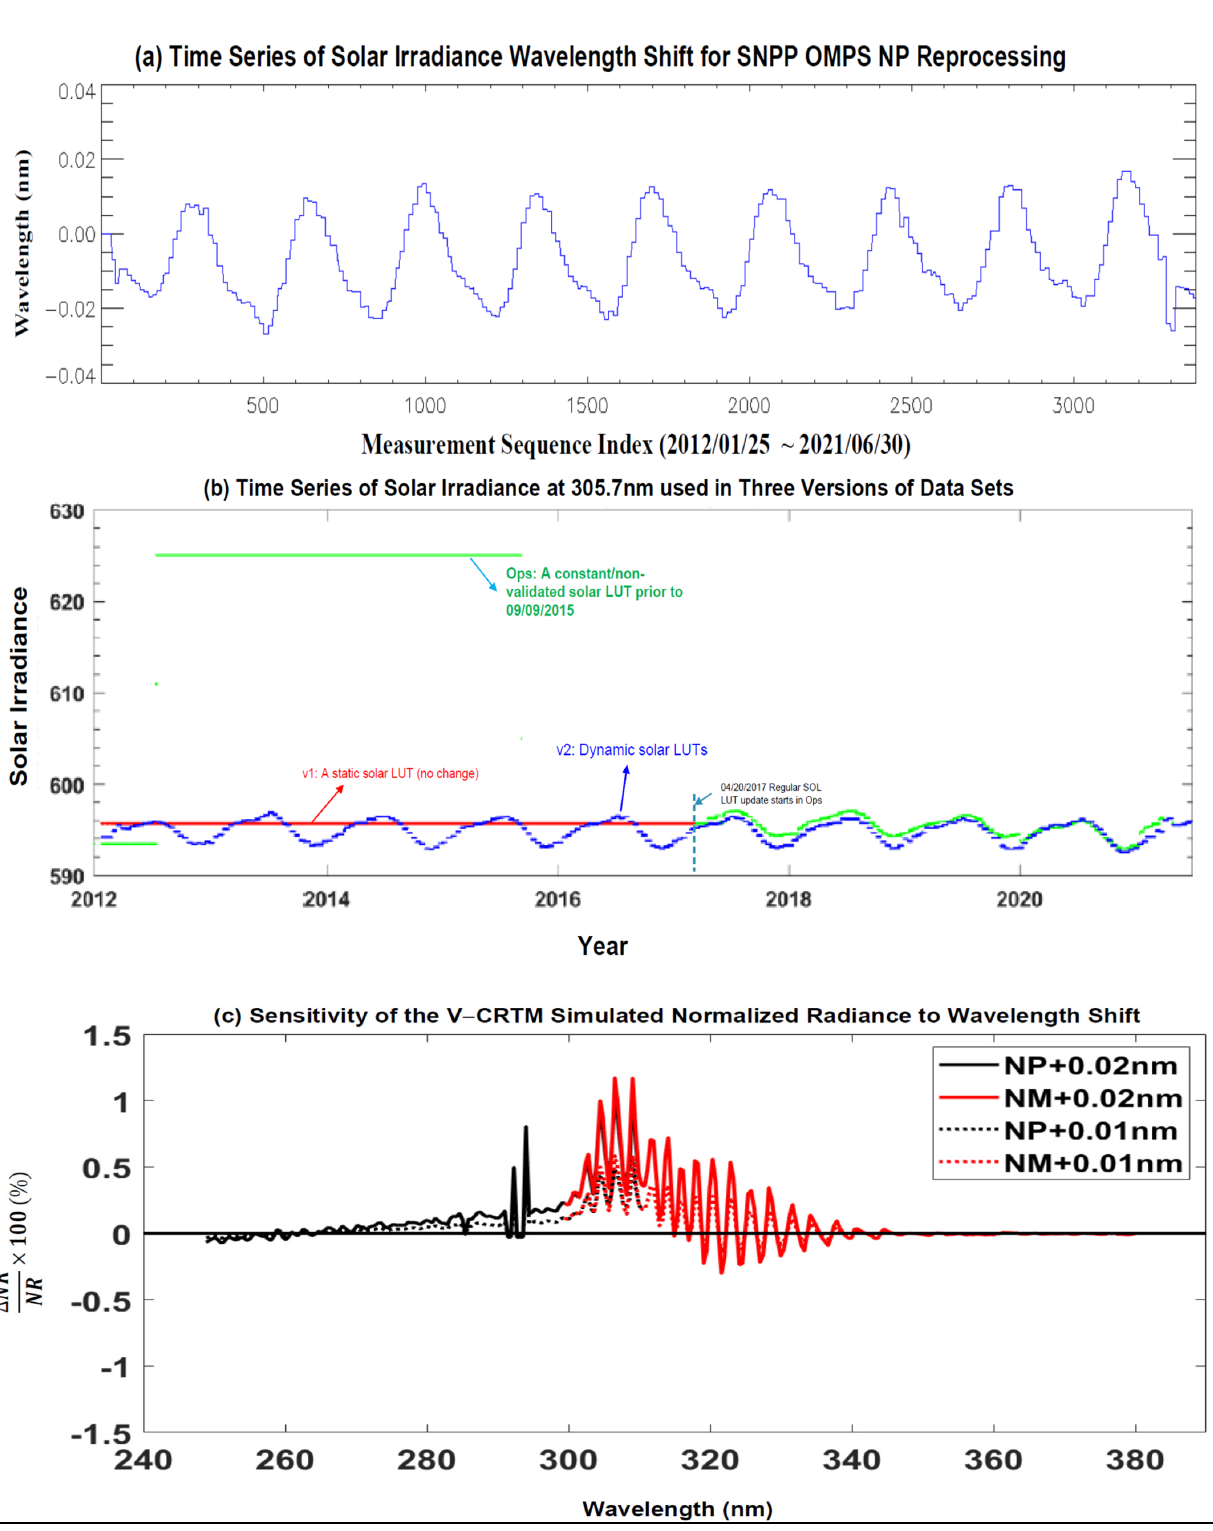
Figure 3. ( a ) Time series of solar irradiance wavelength shifts used in the SNPP OMPS NP new reprocessing. ( b ) Time series of the solar irradiance at 305.7 nm in the SNPP NP solar LUT used in the operational (OPS), the 𝑣 1 reprocessing, and the 𝑣 2 reprocessing. ( c ) Sensitivity of the V–CRTM simulated normalized radiance ( NR ) at the whole OMPS NM and NP wavelengths to wavelength shifts of 0.01 nm and 0.02 nm,